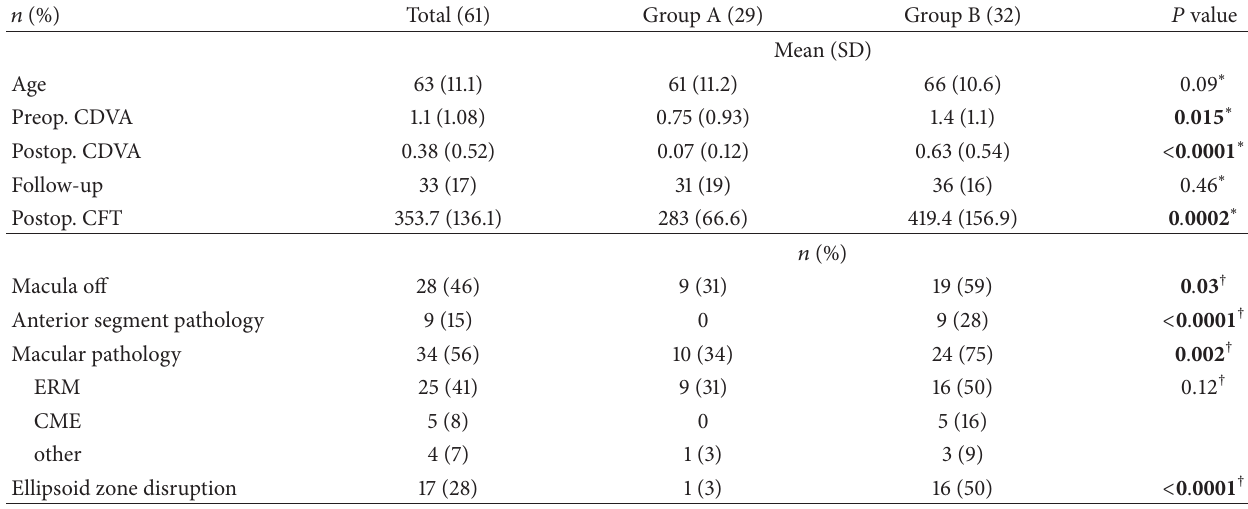
Table 1: Preoperative and postoperative parameters and comparisons between groups.